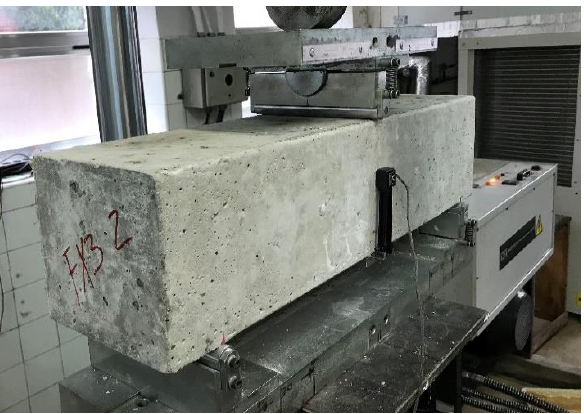
Figure 7. Test set up to ascertain flexural tensile strength according to EN 14651 [58] (Picture by authors). by